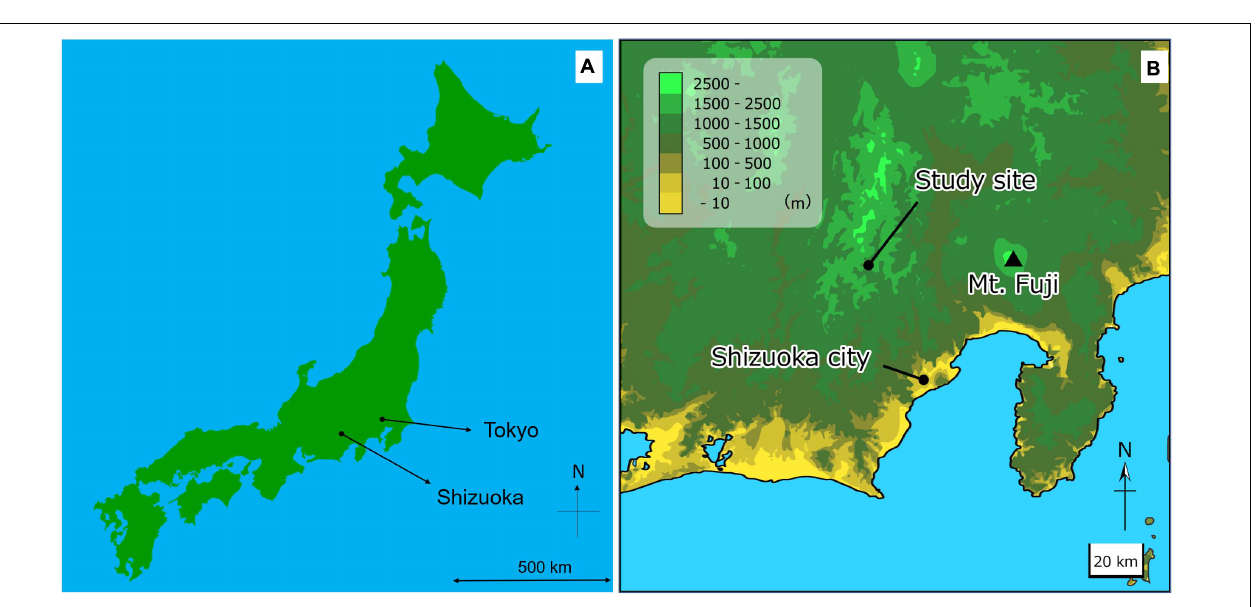
FIGURE 2 | Map of the sample collection area. (A) Map of Japan, and (B) Map of around the sample collection